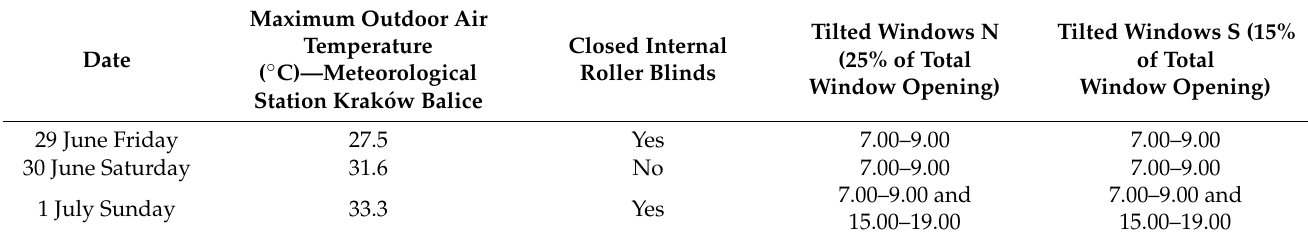
Table 2. Measurement conditions in the sports hall during the three-day summer period.